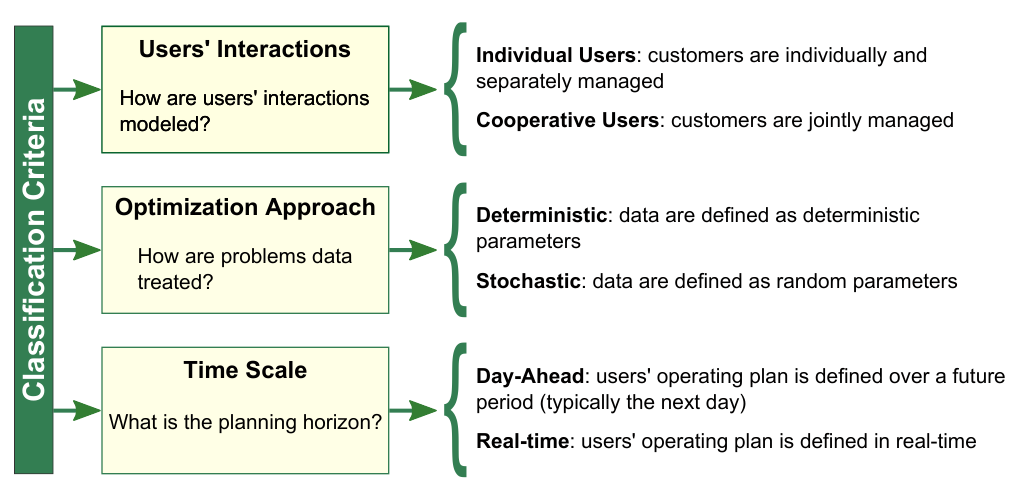
Figure 2. Dichotomies for the classification of demand-side management methods based on optimization